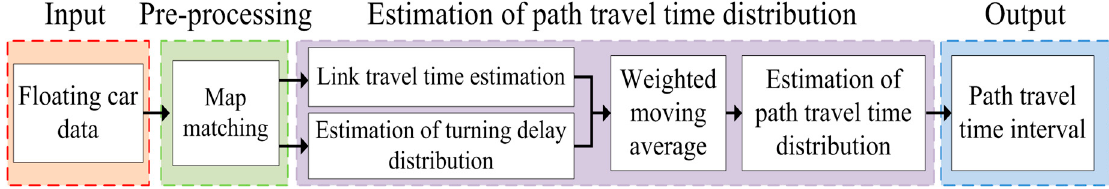
Figure 2. Framework of the proposed method.